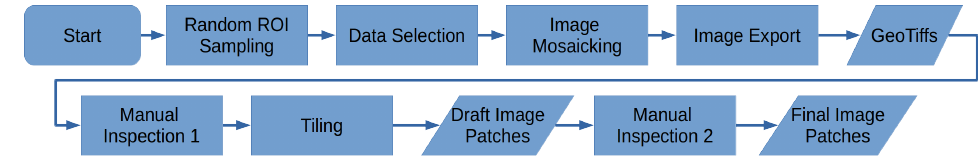
Figure 1. Flowchart of the semi-automatic, Google Earth Engine-based patch extraction procedure.